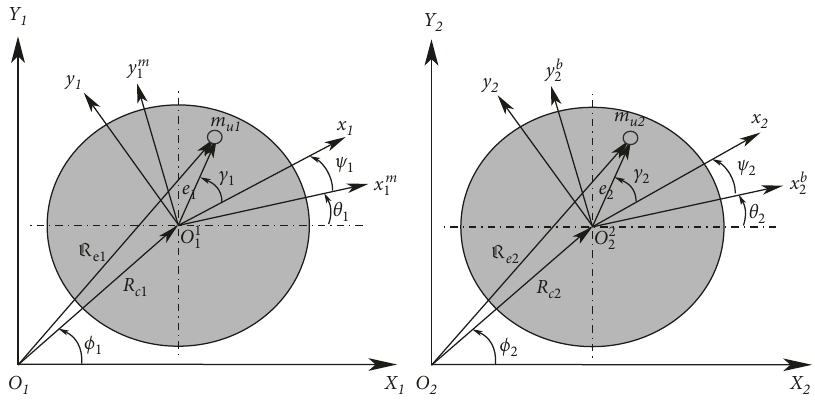
Figure 2: The coordinate system of the coupled shafts with discs 1 and 2,